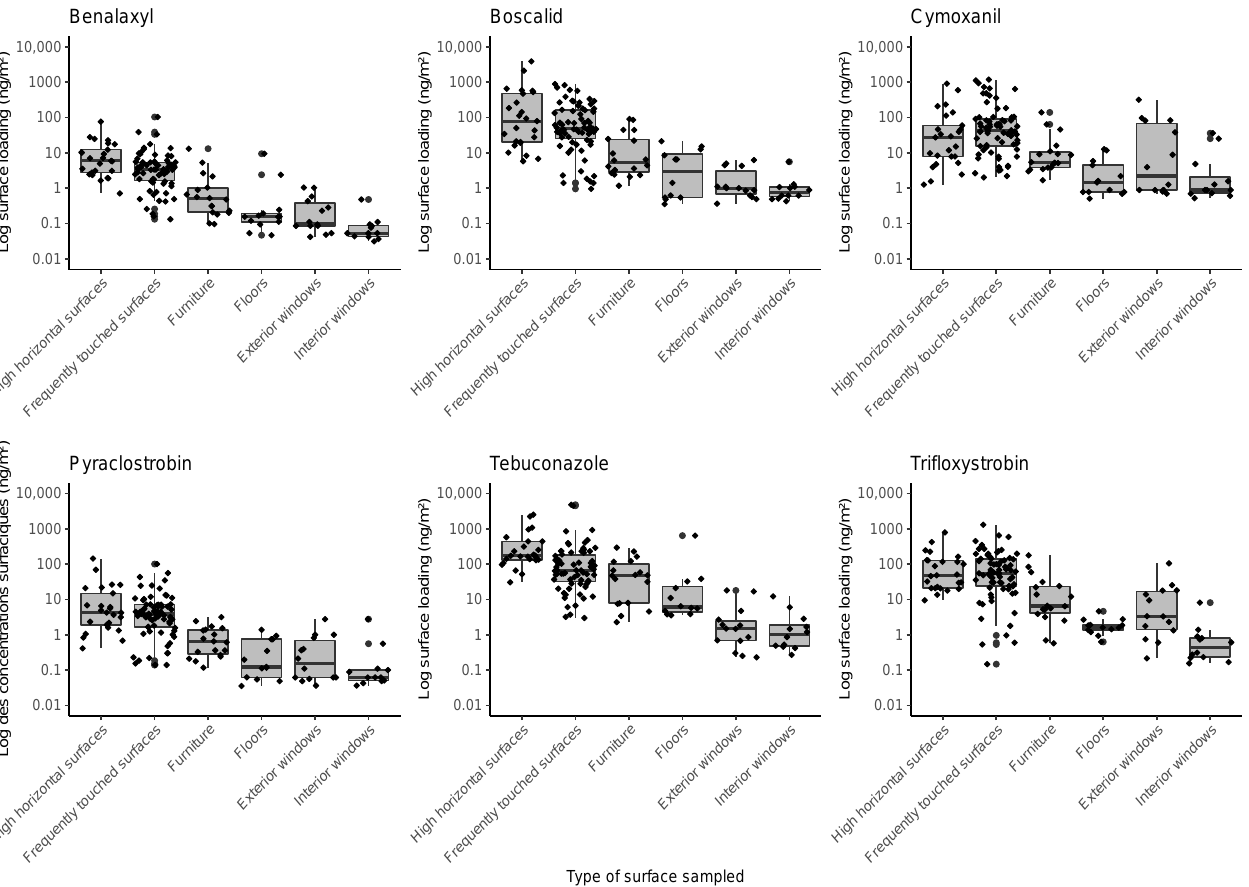
than a week ago.